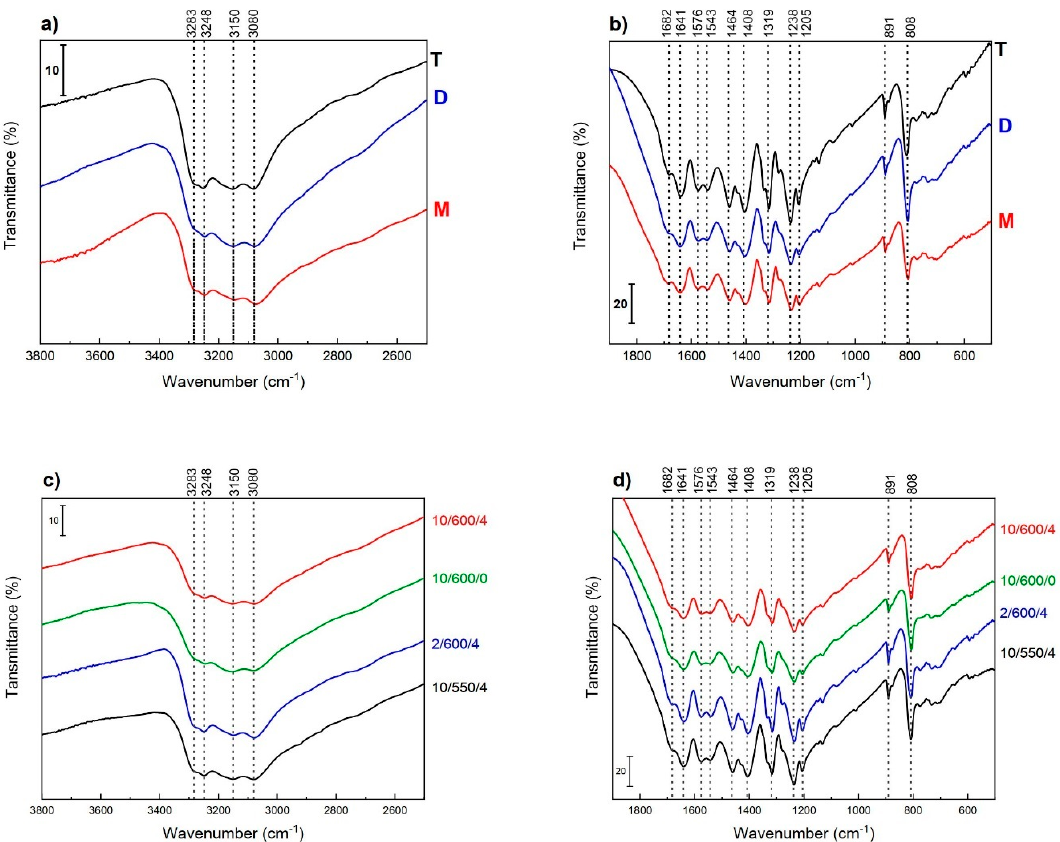
Figure 8. FTIR spectra of carbon nitrides obtained from various precursor ( a , b ) and under various condensation conditions from dicyandiamide ( c , d ).